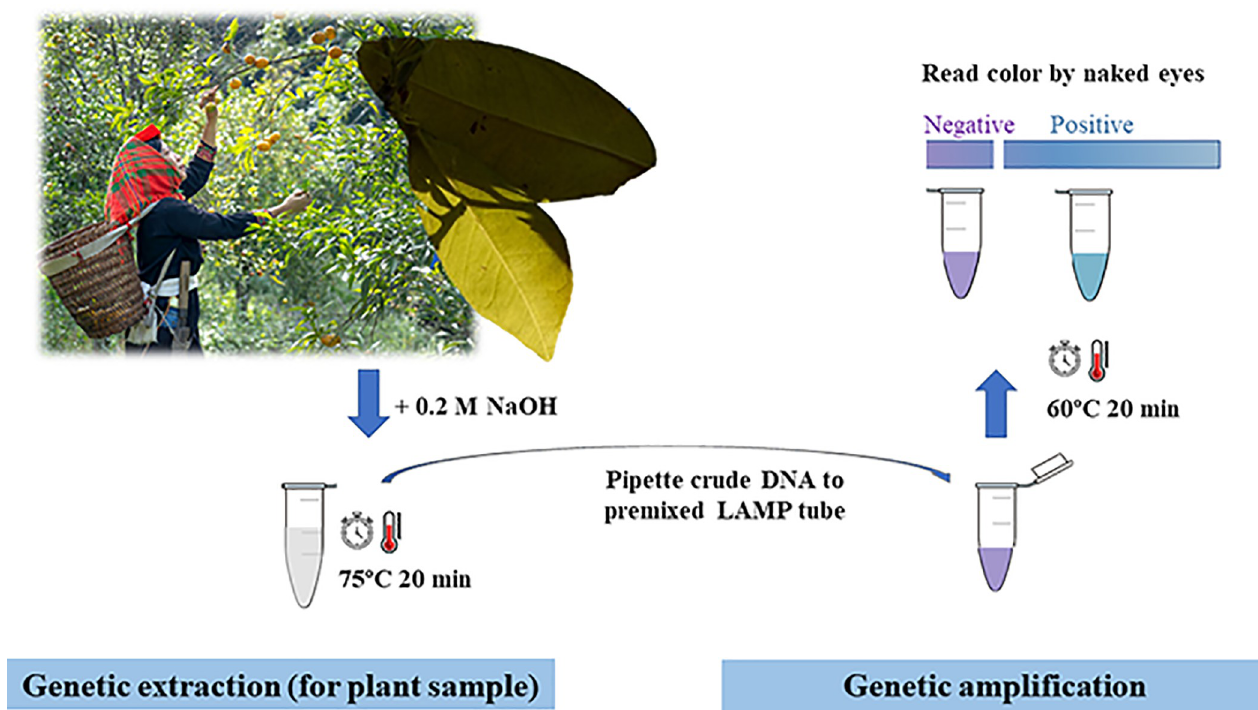
Fig 3. Graphical abstract of C . Liberibacter asiaticus AL-LAMP-HNB assay for potential local plant greening disease detection applications.